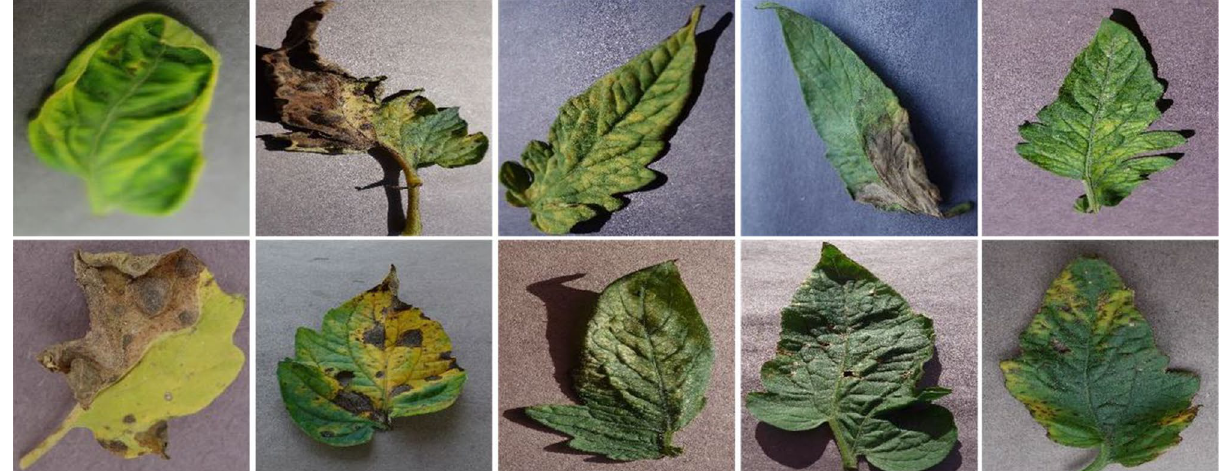
Figure 3. Samples of the PlantVillage dataset.